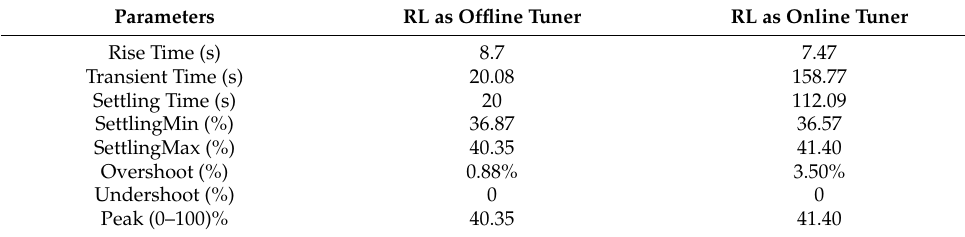
Table 6. Step-response characteristics for systems in Figure